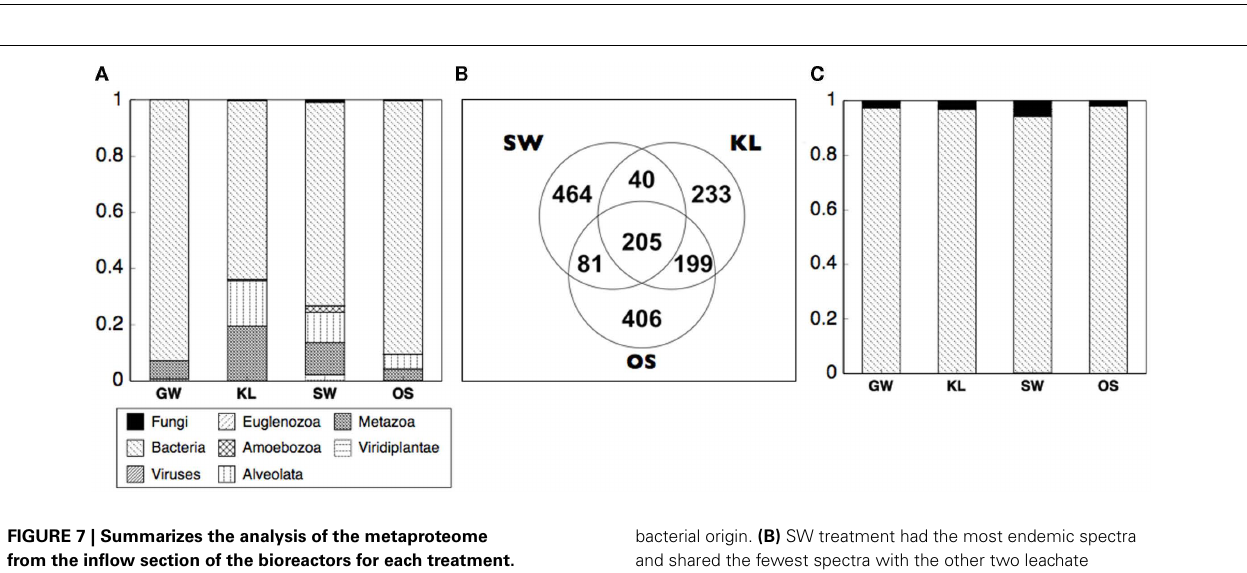
Treatments that are significantly different from one another are denoted with a different letter (a, b, or c) as determined byTukey HSD post hoc analysis. If no letters are present each treatment was statistically indistinguishable.